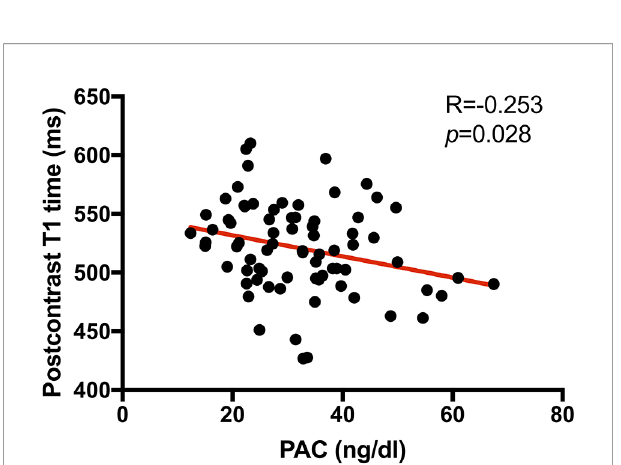
FIGURE 3 | Scatterplot showing the correlation between myocardial postcontrast T1 time (ms) and plasm aldosterone concentration (PAC, ng/dl) in PA patients. Thus, higher PAC was associated with a higher burden of interstitial myocardial collagen deposition (represented by a shorter postcontrast T1 time) in PA patients.